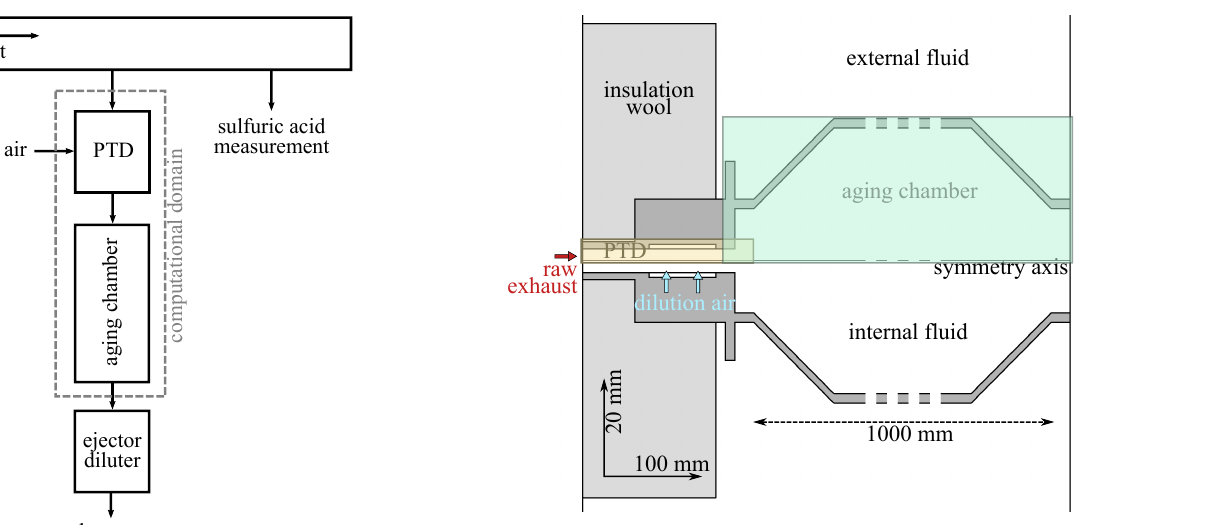
Figure 4. The computational domain. It is an axial symmetric ge- ometry where the raw exhaust is input from the left, and the dilution air is supplied radially from a cylindrical boundary in the PTD re- gion. The PTD is insulated but the latter part lies in stagnant external fluid. Only the ends of the aging chamber are shown, but the length of it is 1m in reality. The figure is scaled vertically with a factor of 5. The yellow (PTD) and the green (aging chamber) boxes present the regions in which the contour plots are plotted in the following